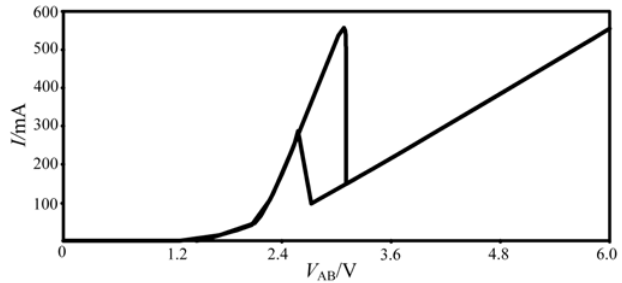
Figure 2. Hysteresis characteristic of the R-HBT-NDR unit.